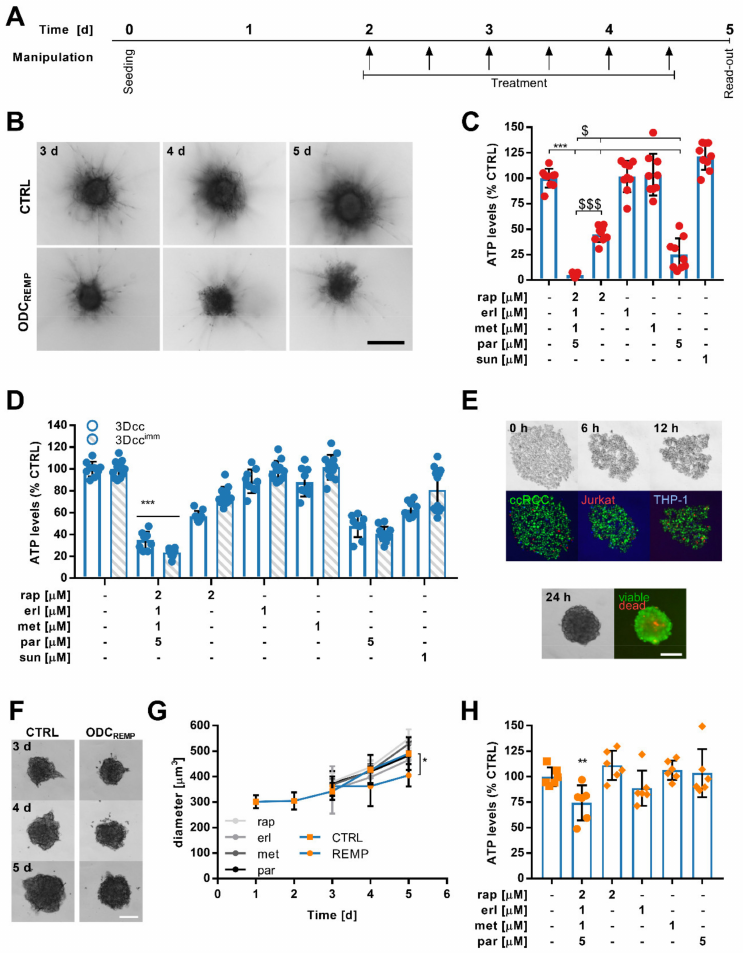
Figure 4. Activity of ODC REMP in in vitro and ex vivo organoid-like heterotypic 3D co-culture systems. ( A ) Timeline of the treatment schedule used for translation in heterotypic 3D co-cultures from cell lines and resected Caki-1-SR clone 1 tumors. ( B ) Caki-1-SR clone 1-based 3D co-cultures (3Dcc) were established in a collagen-rich (0.5 mg/mL collagen type 1) environment to induce a motile phenotype and sprout formation. After three days (3 d) sprouts were formed, which were monitored until 5